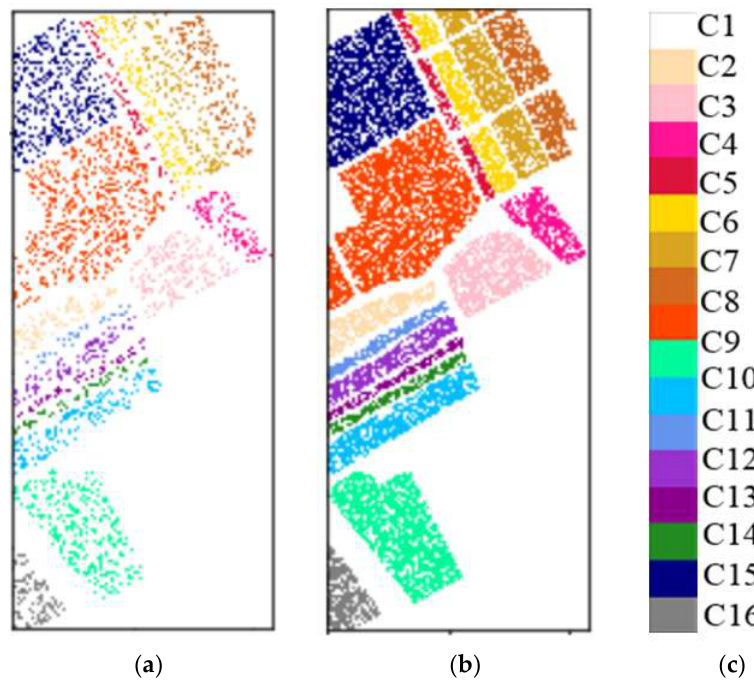
Figure 7. ( a ) Training sample; ( b ) Test sample; ( c ) Tag block.